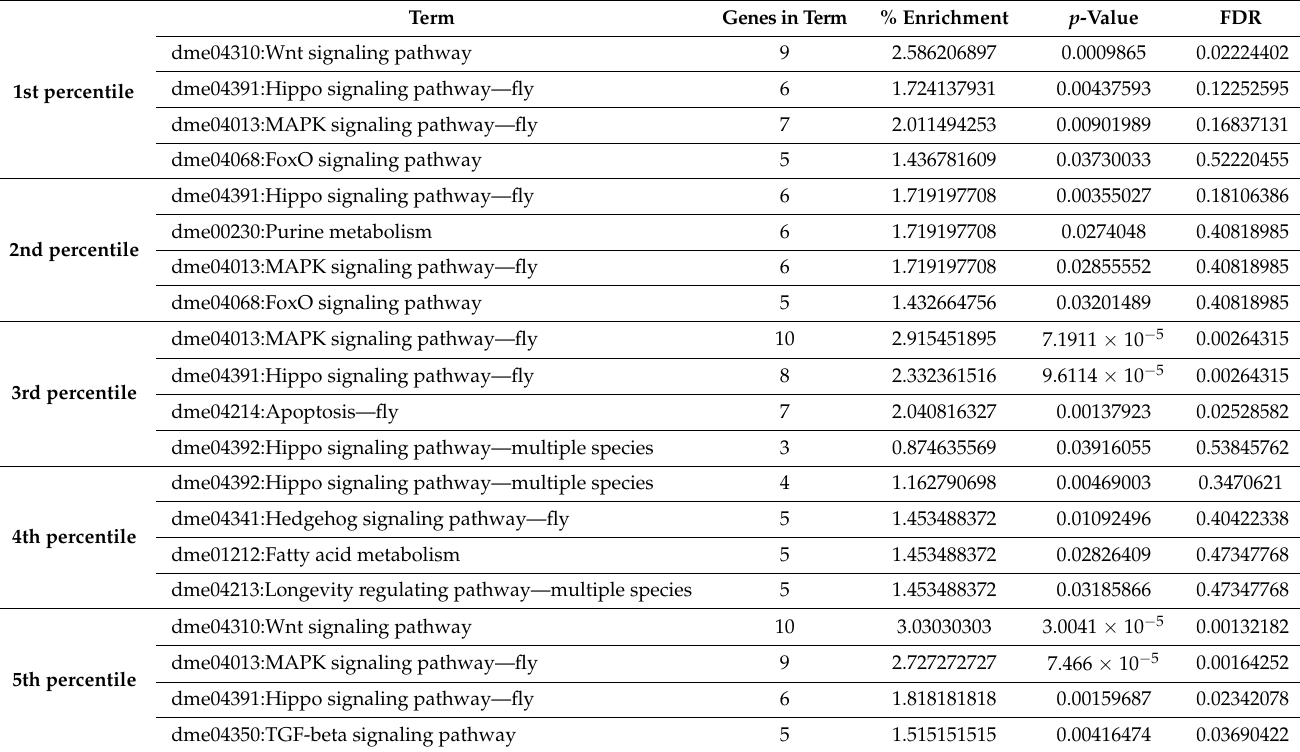
Table 1. KEGG pathways from TaDa-seq annotation genes with significative peaks grouped into five